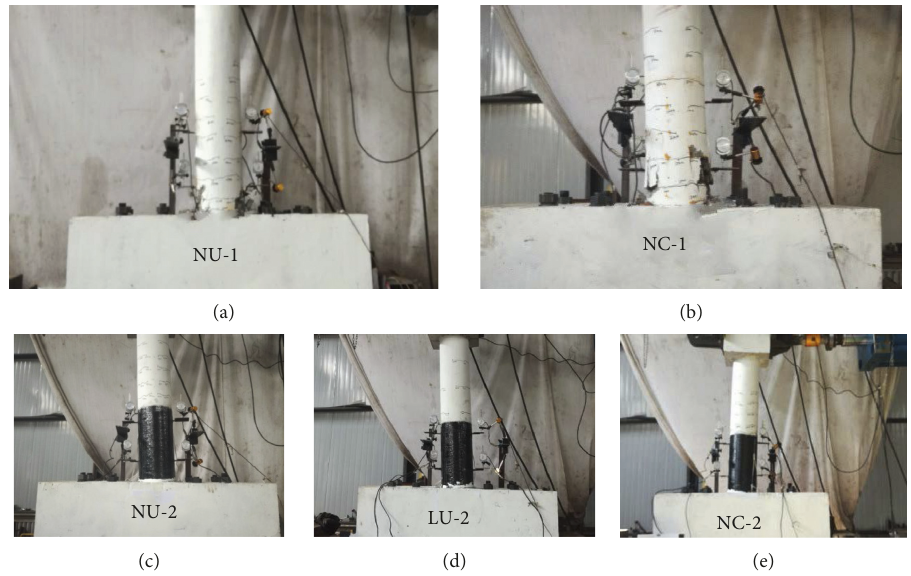
Figure 5: Failure characteristics of specimens: (a) NU-1; (b) NC-1 (c) NU-2; (d) LU-2; (e) NC-2.